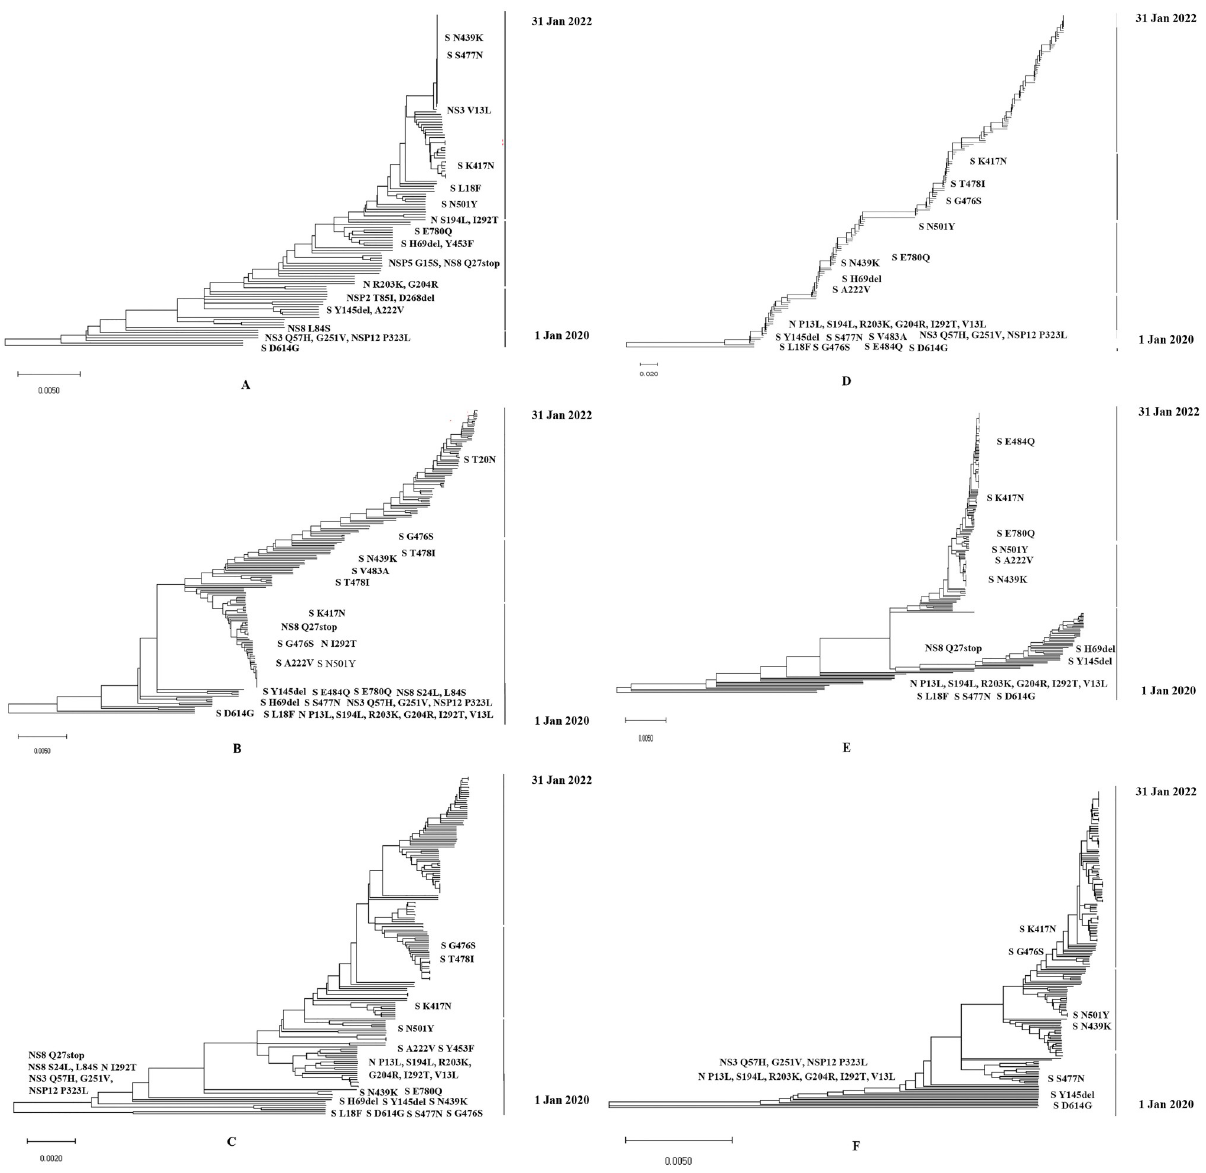
Fig 7. Phylogenomic tree of the whole genome of SARS-CoV-2 including the representative genomes containing significant point mutations. Whole genome with high coverage were selected for every continents. Every phylogenomic tree included at least 10 or more sample sequences collected in every month after December, 2019 to January 2022 in every continents. Reference SARS-CoV-2 strains were selected from NCBI. Trees were built by using Maximum Composite Likelihood (MCL) method and genetic distance was calculated by Kimura-2-parameter model. Phylogenomic trees were generated with 1000 bootstrap replicates of the nucleotide alignment datasets. Six trees represented six continents including (A) Africa (485 whole genomes), (B) Asia (855 whole genomes), (C) Europe (624 whole genomes), (D) North America (738 whole genomes), (E) Oceania (395 whole genomes), and (F) South America (625 whole genomes), respectively. Wuhan-Hu-1/2019 was used as reference sequence in this